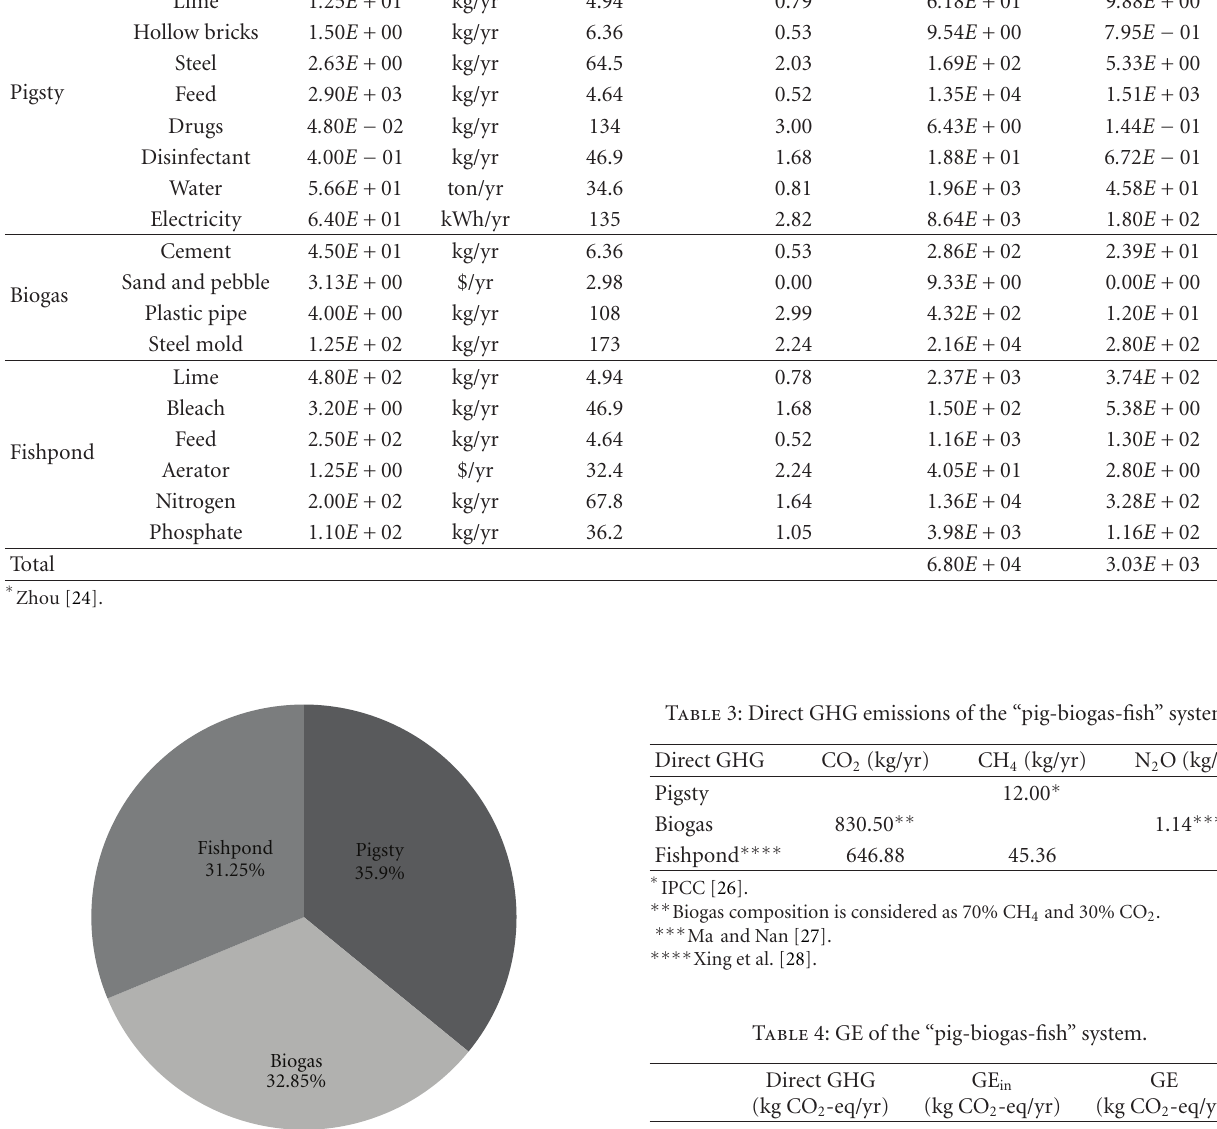
Figure 3: NE cost fractions for the “pig-biogas-fish” system.